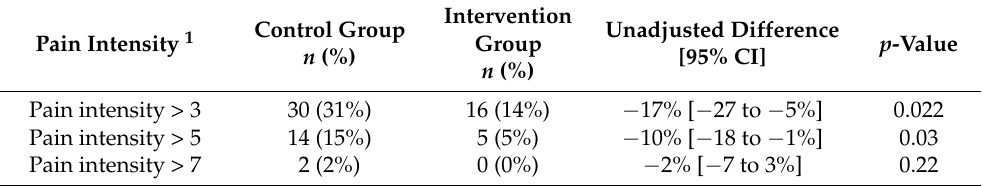
Table 3. Comparison of pain at different thresholds between the control and intervention groups with two different hypotheses about the missing